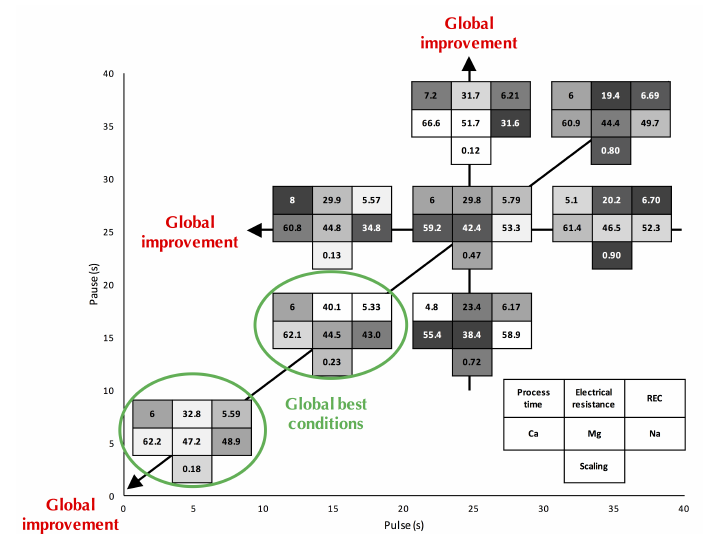
Figure 13. Schematic representation of the studied surface area comprised in the eight PEF conditions tested. Each condition is represented by a table including in the first row: its process duration (in h), its final electrical resistance reduction from the CC application results reported by Dufton et al. [113] (in %) and its relative energy consumption (in Wh / g of lactic acid removed). The second row includes the demineralization rates of calcium, magnesium and sodium (in %), while the third row report the amount of scaling on the AEMs (in g / 100 g of dry membrane). The shades of grey represent the position of the condition among the others: the lighter the grey, the better the result in term of acid whey treatment (adapted from Dufton et al.